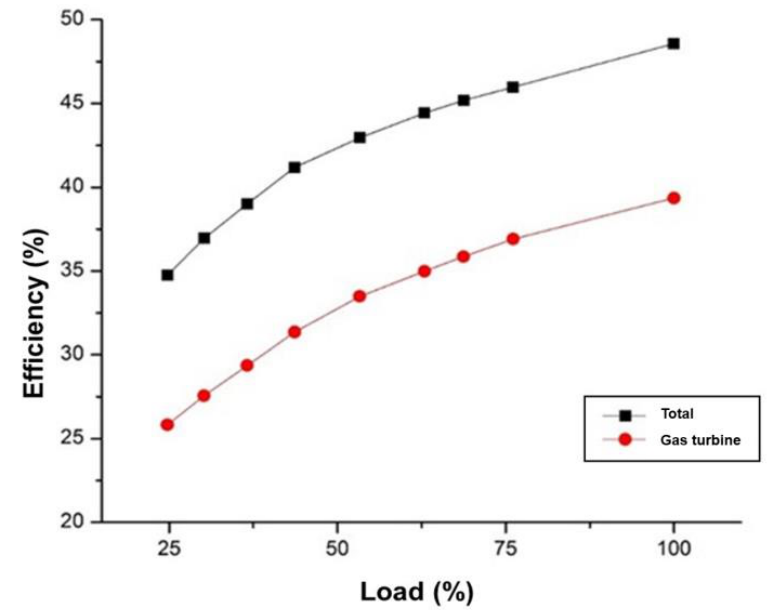
Figure 8. E ffi ciency of the system versus engine Figure 8. Efficiency of the system versus engine load.